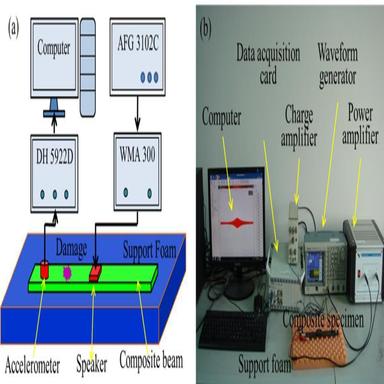
Experimental setup: (a) schematic diagram and (b) image.